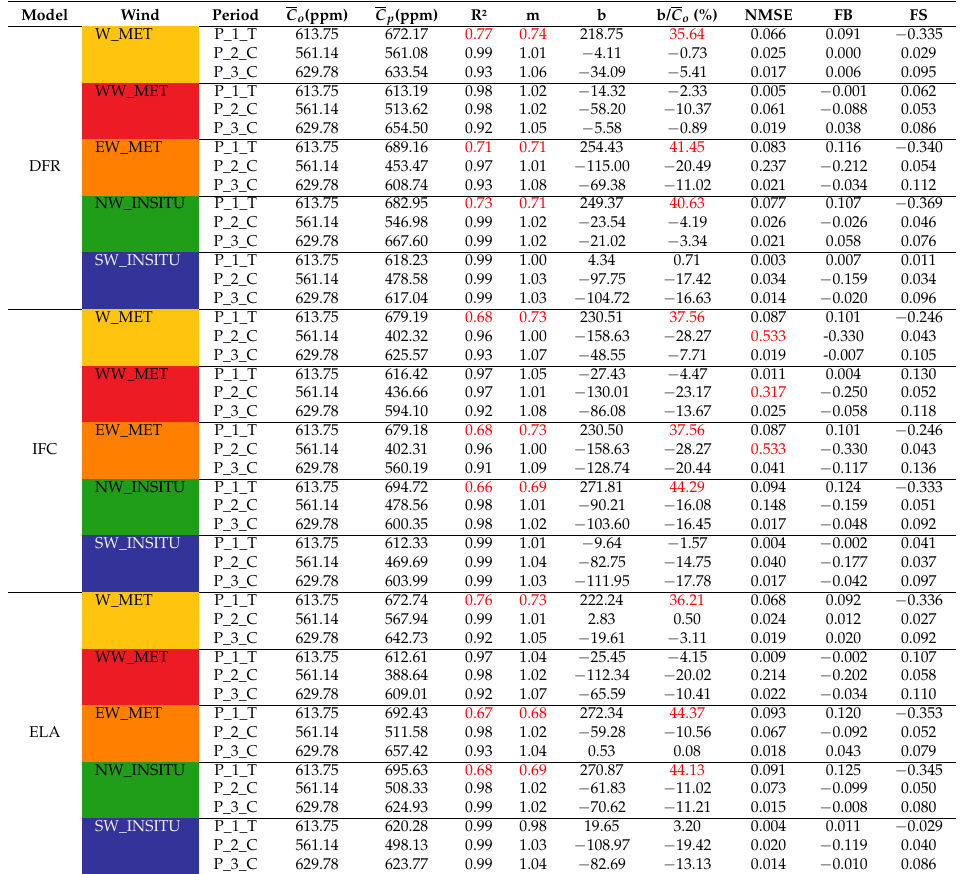
Table 5. Results of the fifteen combinations according to ASTM D5157. The colors are the same as those defined in Figure 5. (Text in red color the values that do not meet the